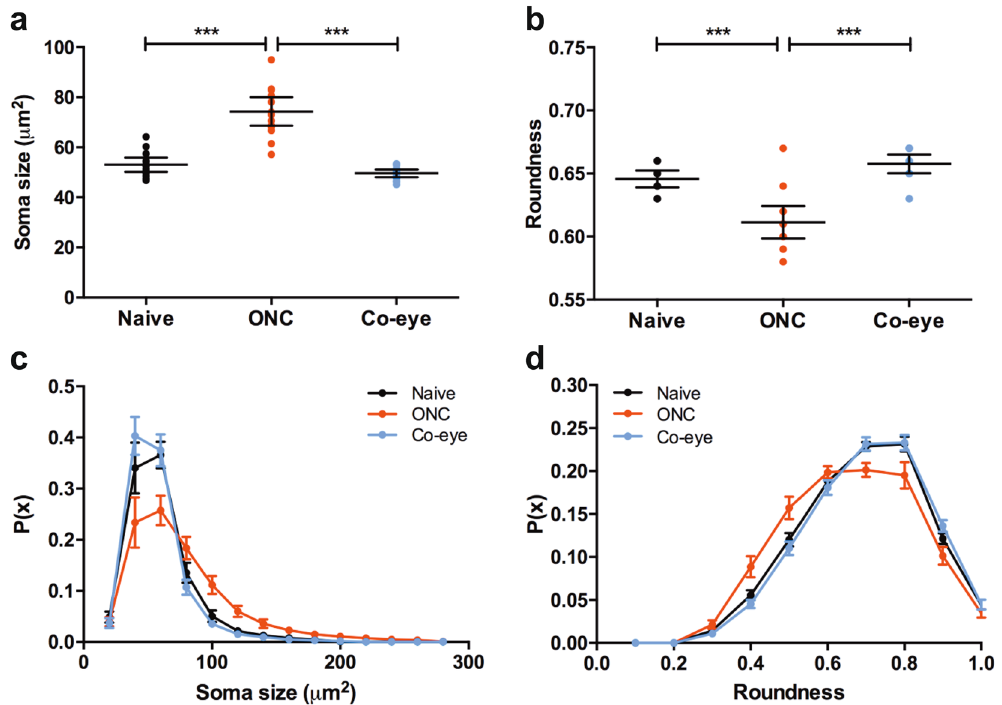
Figure 3. Microglia soma size and roundness. ( a ) Microglial activity following ONC is associated with an increase in average cell body area; while ( b ) roundness of the cell soma decreases (one-way ANOVA with Tukey’s post hoc test). These signs of microglial activation are not seen in the retina of the contralateral ONC eyes. ( c ) Distribution analysis of soma area shows a shift from small to larger cell body sizes after ONC; and ( d ) distribution analysis of circularity indicates that these cells are more likely to be more irregularly shaped ( i.e ., to have a lower roundness index). Data are depicted as mean ± 95% confidence